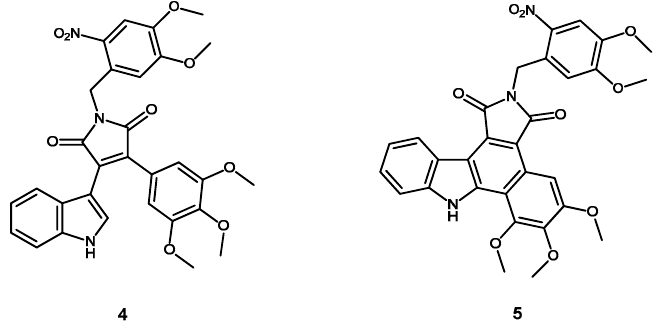
Figure 2. Designed caged compounds 4 and 5 with the 4,5-dimethoxy-2-nitrobenzyl (DMNB) protecting group attached to the maleimide resp. carbazole in order to prevent hinge binding.